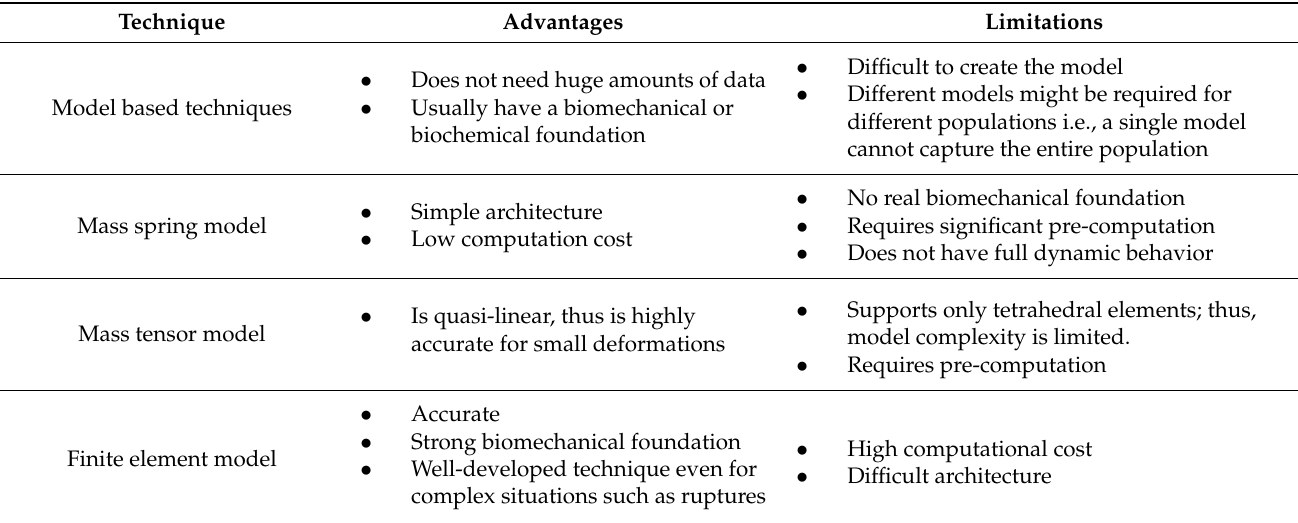
Table 1. Comparison of FEM, MSM and MTM model-based prediction